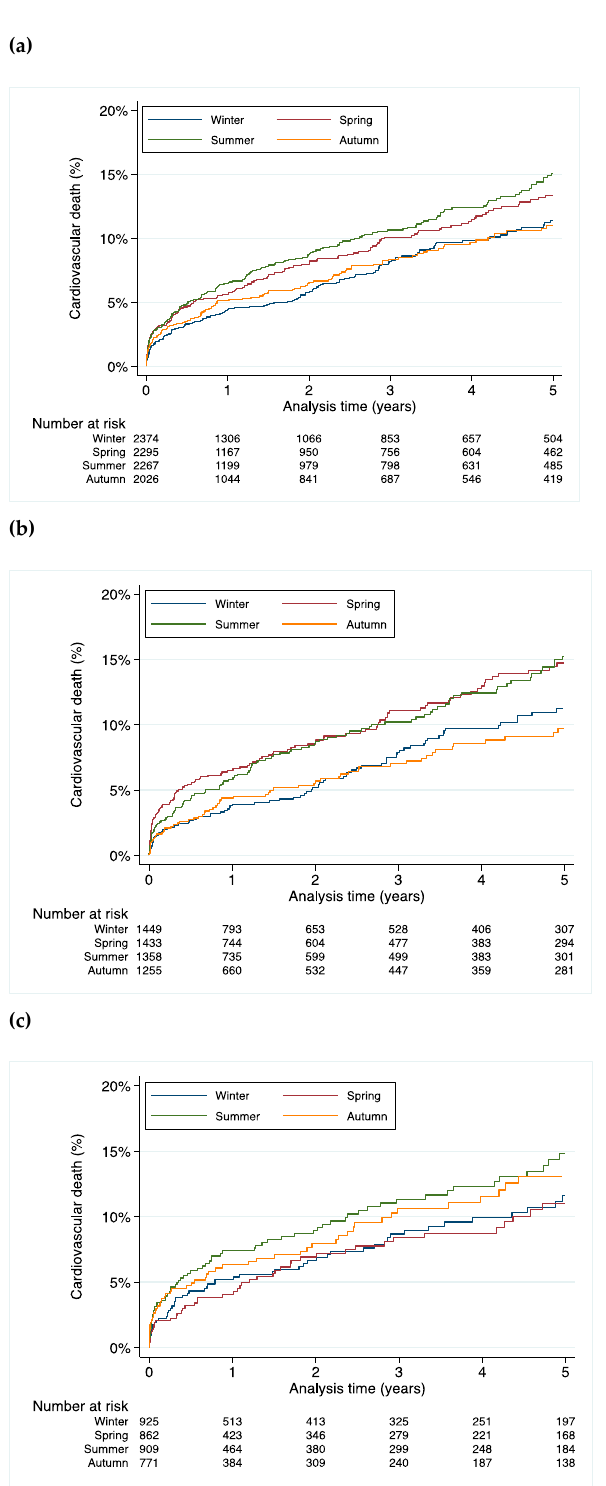
Figure 2. Cardiovascular mortality stratified by season of birth for ( a ) all patients, ( b ) male patients and ( c ) female patients.